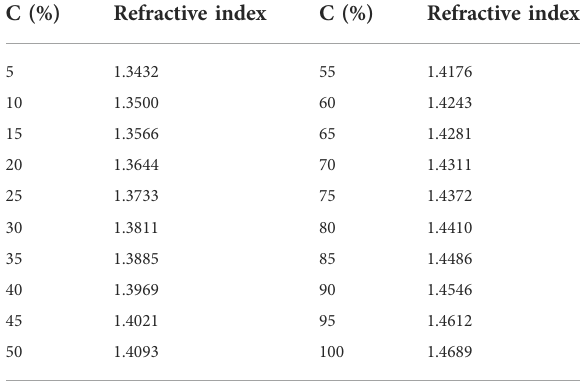
FIGURE 6 Fitting relationship between glycerol concentration and the Fano resonance wavelength.